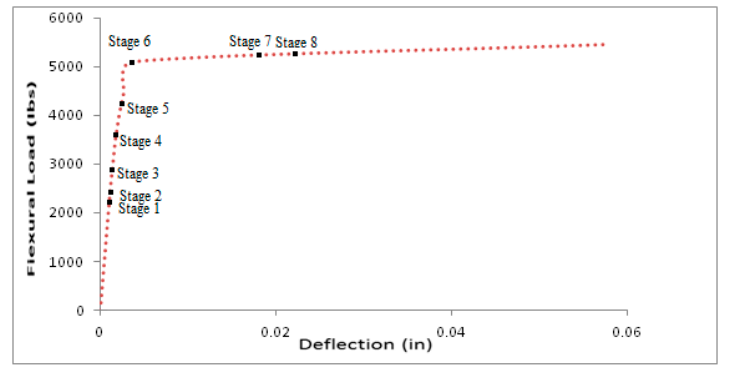
Figure 8. Numerical flexural response of FRP strengthened concrete beams and the stages of concrete crack at 100 ° C. ( a ) The events of simulation loadings; ( b ) The stages of concrete